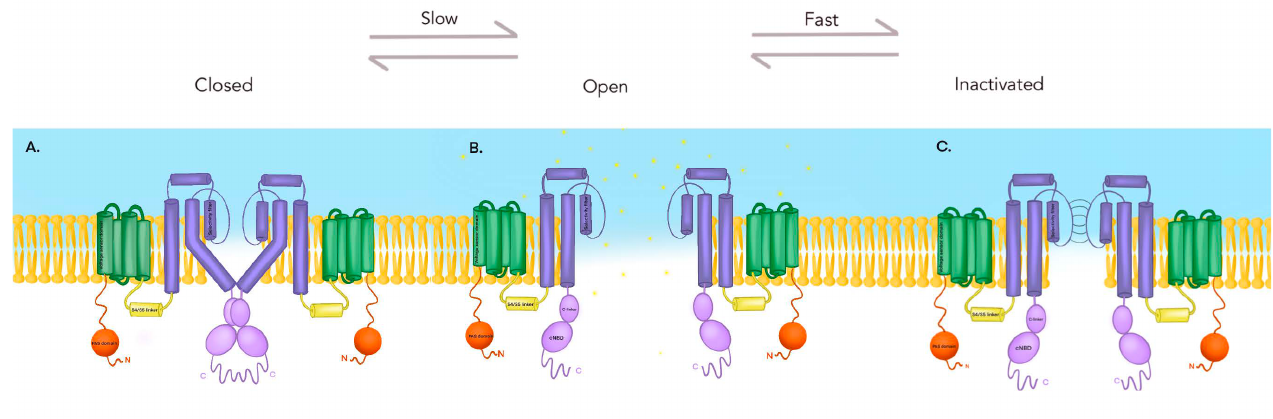
Figure 1. Gating kinetics of the Kv11.1 channel. The Kv11.1 channel can exist in 3 states, open, inactivated, and closed. An important characteristic defining Kv11.1 is its rapid inactivation and recovery from inactivation, as opposed to the slow process of deactivation (closure). Figure adapted from [44]. ( A ) Kv11.1 in the closed state, the four S6 domains crisscross near the cytoplasmic domain to narrow the opening and avoid ion flow. Contains a voltage sensor domain (green) encompassed in the first four transmembrane helices (S1–S4), a pore (dark purple) that serves as the conducting ionic potassium pathway. Each alpha subunit of this tetrameric channel (only two subunits are shown) contains an amino terminus (orange) and a carboxyl terminus (light purple), C-linker and cNBD (cyclic nucleotide-binding homology domain). Figure adapted from: [44] ( B ) Kv11.1 in the open state, the four S6 domains spread outwards to allow the passage of potassium ions. Figure adapted from: [44]. ( C ) Kv11.1 in the inactive